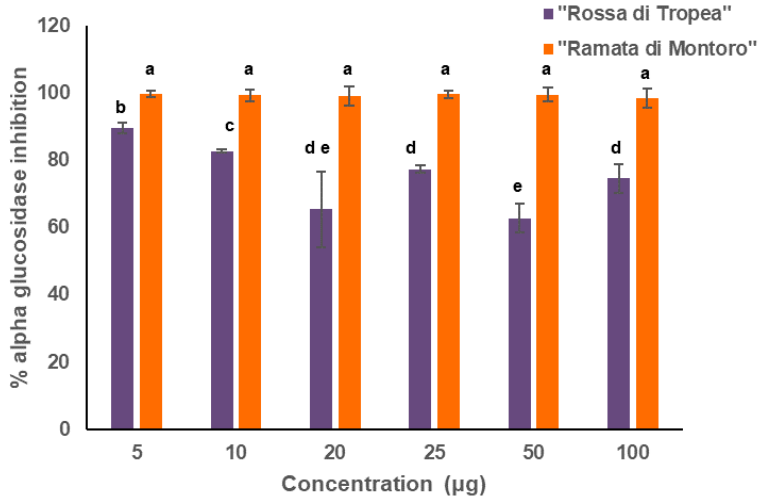
Figure 2. α -glucosidase inhibitory activities of “Ramata di Montoro” and “Rossa di Tropea” extracts at different concentrations. Value represents the mean of three replicates. Different letters denote significant differences among tested concentration within each extract by analysis of variance [ANOVA]. Statistical significance was defined as p < 0.05, using Tukey’s post hoc test for mean separation. Table 4. α‐ glucosidase inhibitory activity of major compounds of “Ramata di Montoro” and “Rossa di Tropea” onion skin extracts.